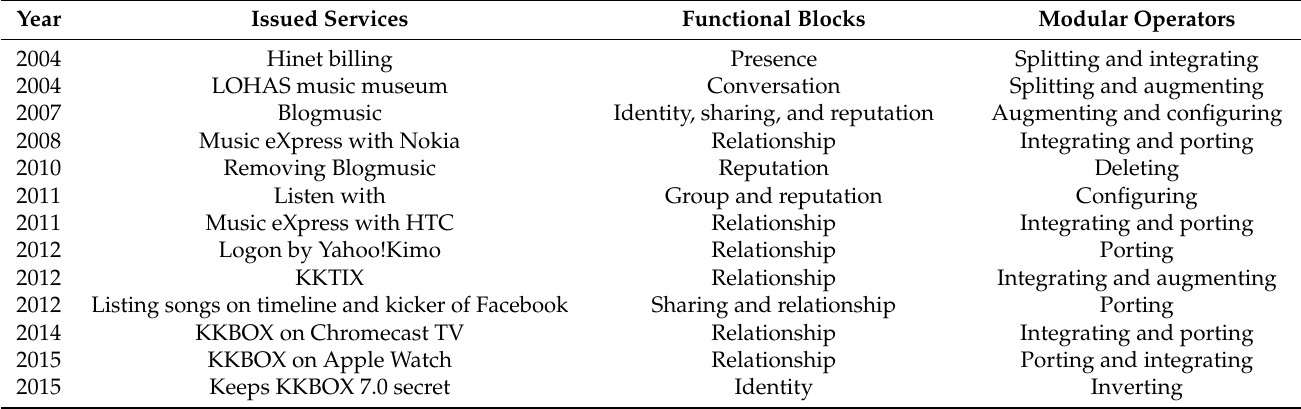
Table 2. KKBOX builds the platform of functional blocks by manipulating modular